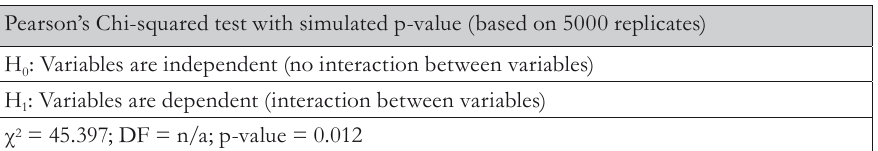
Tab. 2 - Q1a Chi-squared Test and p-value. Source: authors